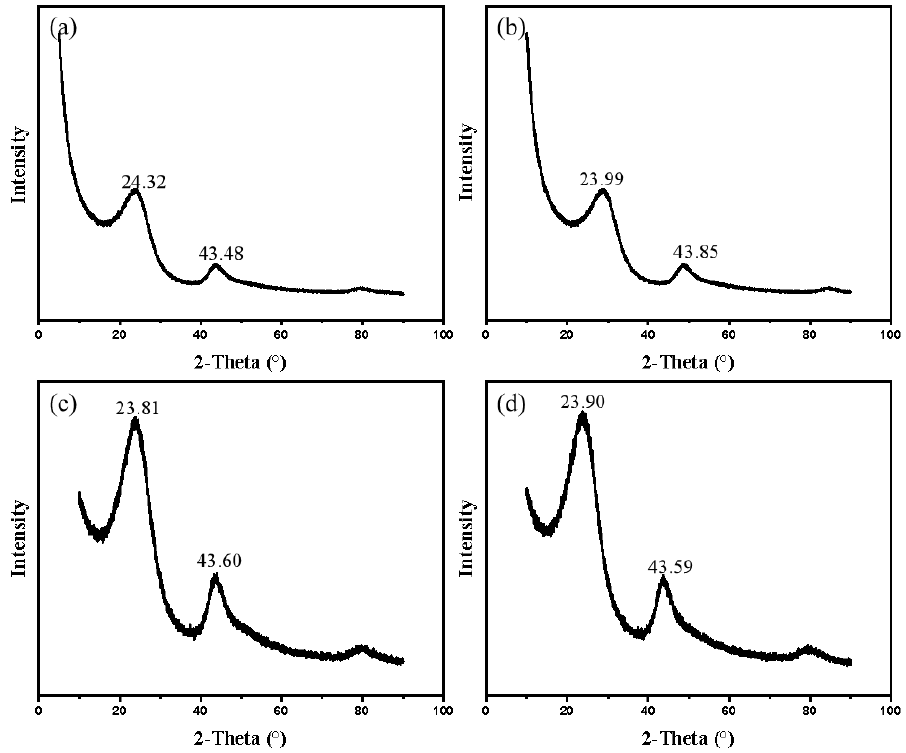
Figure 6. XRD patterns of different sugar-derived carbons prepared at 1200 °C. ( a ) Glu−PAM. ( b ) Fru−PAM. ( c ) Mal−PAM. ( d ) Suc−PAM. ( b ) Fru − PAM. ( c ) Mal − PAM. ( d ) Suc −